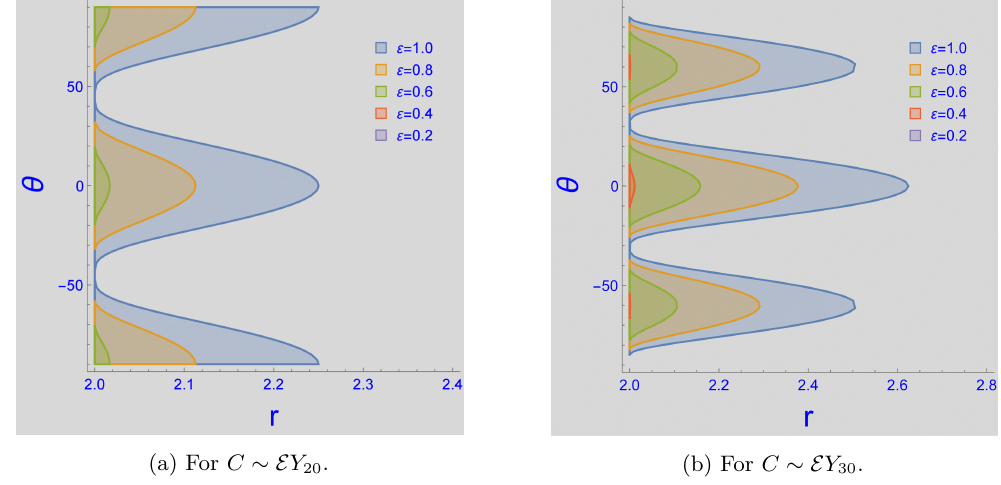
Figure 1 . Angular dependence of the supertranslation horizon r SH ( θ ) for the choice of C ( θ ) given in (2.7) with ‘ = 2 (Left panel) and ‘ = 3 (Right panel). Different colors indicate different values of E as shown by the legends. Note that the supertranslation horizon is outside the Killing horizon at r = 2 M but inside the photon sphere of the Schwarzchild black hole at r = 3 M . On the other hand, for the case with ‘ = 1 (not shown) the supertranslation horizon is inside the Killing horizon and